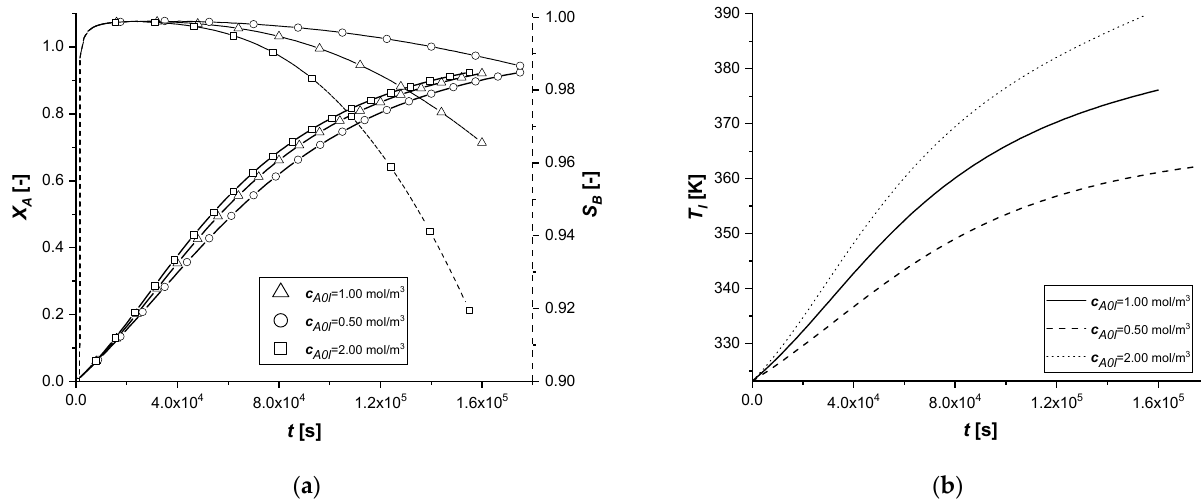
Figure 28. EY c A 0,l investigation. ( a ) Bulk profiles over time of X A and S B . ( b ) Bulk profile of T l over time. The results demonstrate how the chemical process behaves consistently with respect to the decrease or increase of the parameter c A 0,l . In all the cases, the reaction times, for obtaining the desired conversion, are similarly decreasing moderately with the increment of the available reagent. ES is the catalytic case most influenced by the parameter, proba- bly due to the immediate availability of the catalytic zone, unlike the other two cases. Finally, it is interesting to notice, again in the case of the ES, how the slope of the intraparticle profiles of component A changes at the entrance to the solid ( x = 1) due to the different concentration gradients at the interface. 3.2.7. Liquid–Solid Mass Transfer Coefficient The liquid–solid mass transfer coefficient under standard conditions is sufficiently high to keep the external diffusion effects negligible. In this study, the response of the system was evaluated by assuming that the resistance to transport on the surface of the catalytic particle becomes influential in the reactive process. The comparison between the solid side and liquid side concentration profiles calcu- lated for all the catalytic cases are reported in Supplementary Materials in Figures S73– S81. The details of each conversion, selectivity, and liquid side temperature profiles, cal- culated for all catalytic cases, are shown in Figures 29–31.